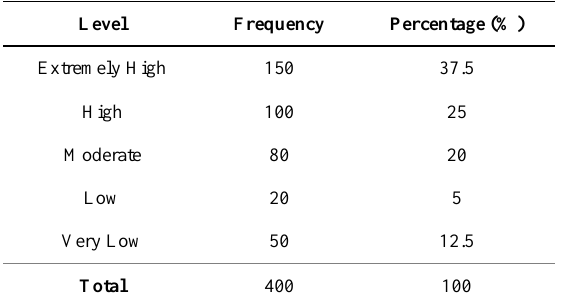
Table 2. Analysis of the Level of Utilization of Oil Palm Biomass